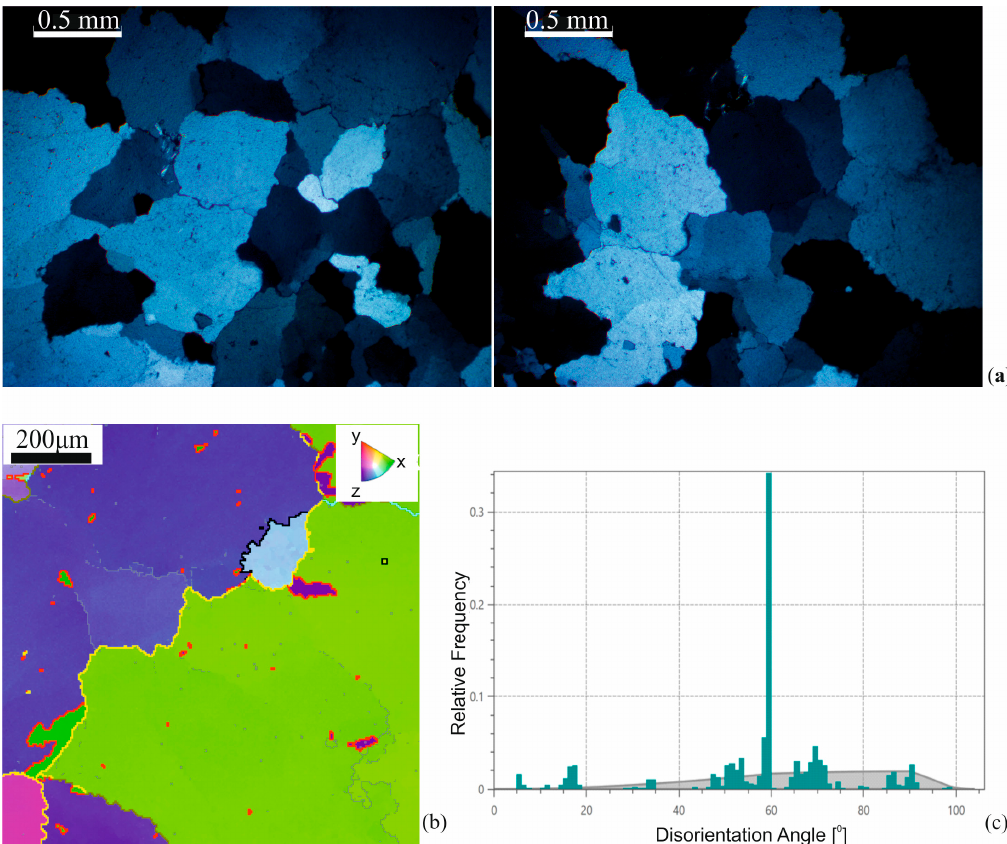
Figure 10. Features of the microstructure of vein quartz type E: ( a ) optical micrography of the coarse-grained quartz; ( b ) the processed EBSD band contrast (BC) + inverse pole figure (IPF) map with the color coded boundary indicating the angle of boundary misorientation; and ( c ) the disorientation angle distribution and the theoretical curve (gray color) with a peak around 60° associated with the Dauphiné twins.